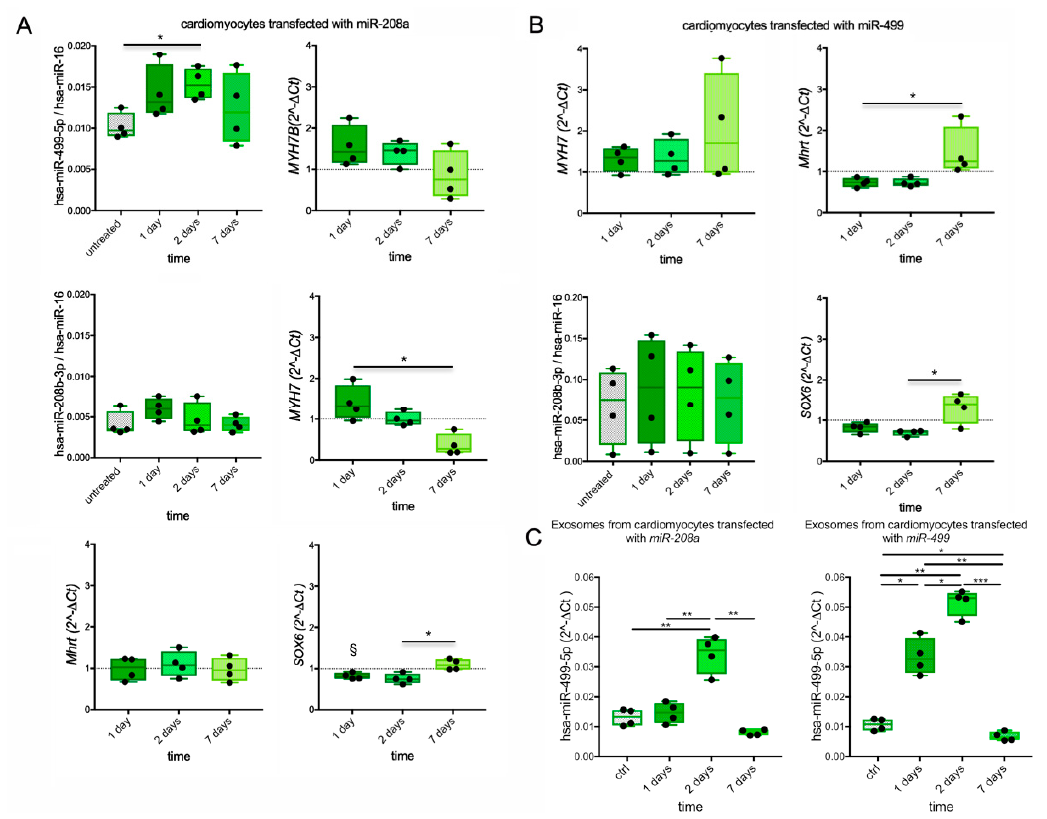
Figure 5. MYHs , MyomiRs, and SOX6 expression in transfected cardiomyocytes from iPSC. The levels of expressed miR-499 , MYH7B, MYH7, Mhrt, miR-208b , and SOX6 by RT-qPCR in cardiomy- ocytes differentiated from iPSC and transfected with miR-208a are shown at different time points ( A ). The expression of MYH7, Mhrt, miR-208b , and SOX6 determined in cardiomyocytes after transfection with miR-499 is plotted ( B ). The gene expression is presented as the ratio between 2ˆ − ∆ Ct in treated vs. untreated cells (ratio control value =1 is indicated by dotted line where applicable). Amount of miR-499 released from transfected cardiomyocytes into culture supernatants is also shown ( C ). Values are presented as boxes (min to max), and dots indicate single sample values. ANOVA and Friedman tests are applied. p -value < 0.05 is considered significant and shown as *; p < 0.01 is indicated by **, and p < 0.001 by ***. Significant difference ( p -value < 0.05 ) vs. untreated cells is indicated by